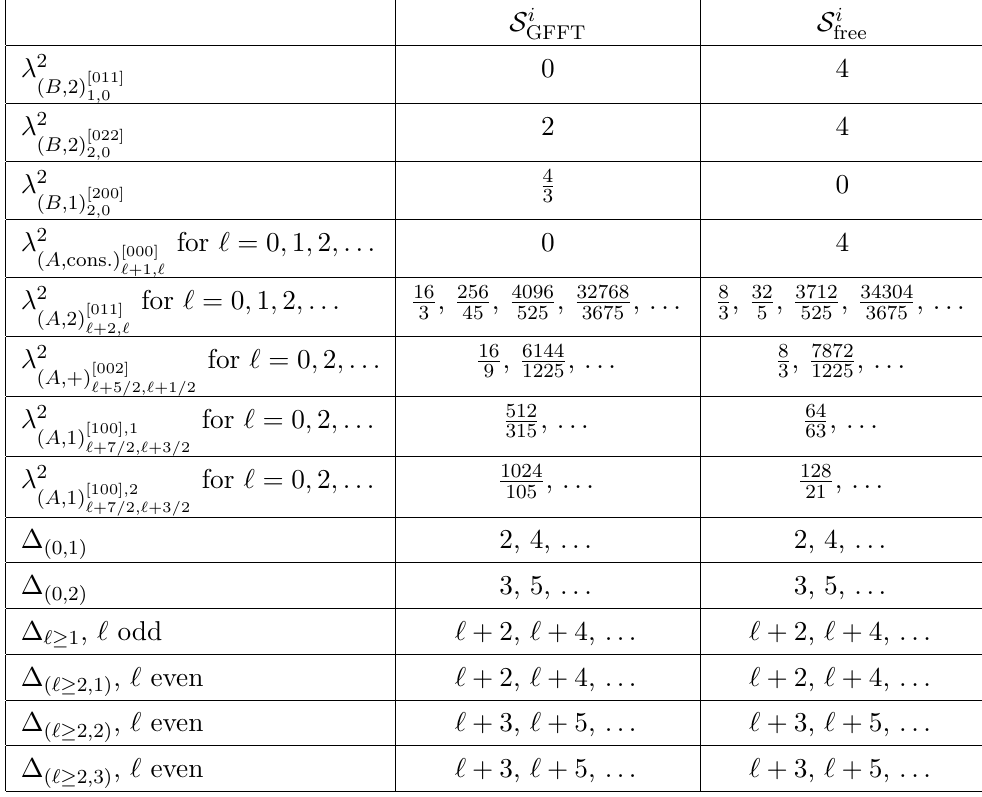
and the free GFFT